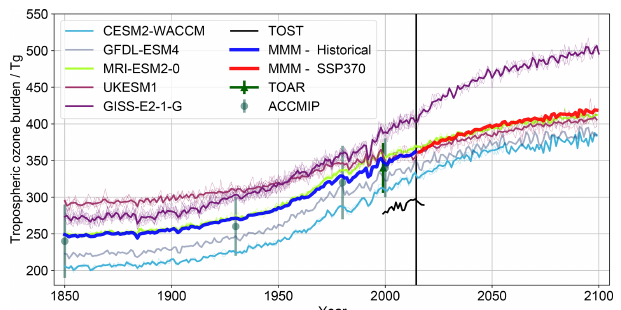
Figure 8. Evolution of tropospheric-ozone burden integrated from 90 ◦ S to 90 ◦ N for the period 1850–2100. Models are shown as coloured lines as in the caption. Thick blue line: multi-model mean for CMIP Historical experiment. Red line: multi-model mean for ScenarioMIP ssp370 experiment. TOST burden is show as black line, TOAR multi-model mean as a green triangle and ACCMIP multi-model mean for time slice experiments as dark green